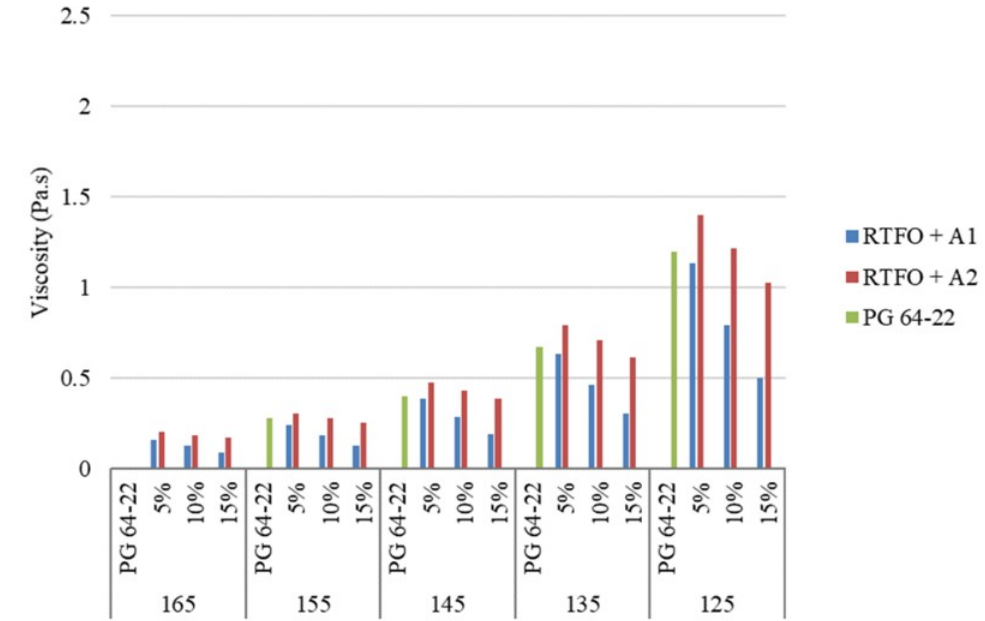
Figure 3. Viscosity of the RTFO-aged samples with the additives of A1 and